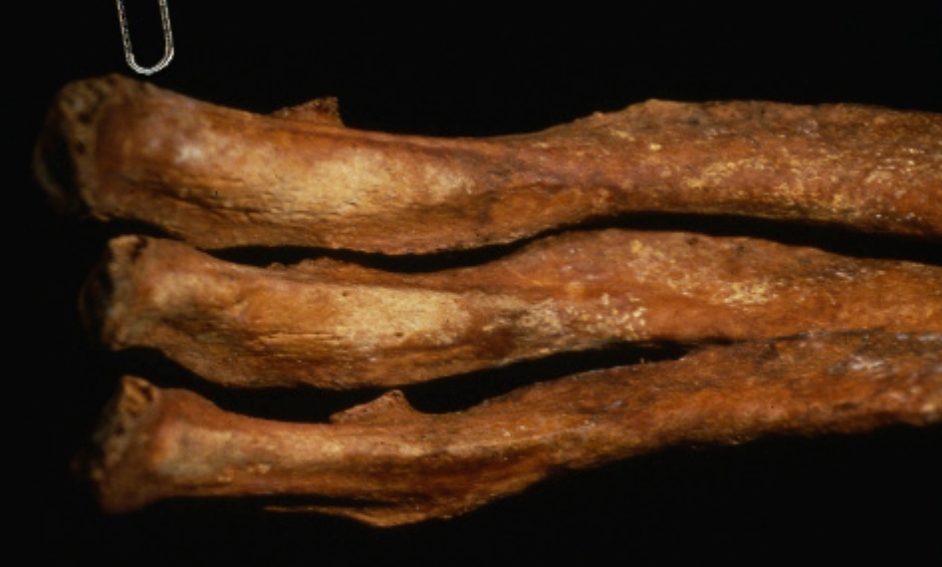
Figure 2. The ribs of JB55 showing pathological lesions consistent with chronic lung infection, perhaps caused by tuberculosis.